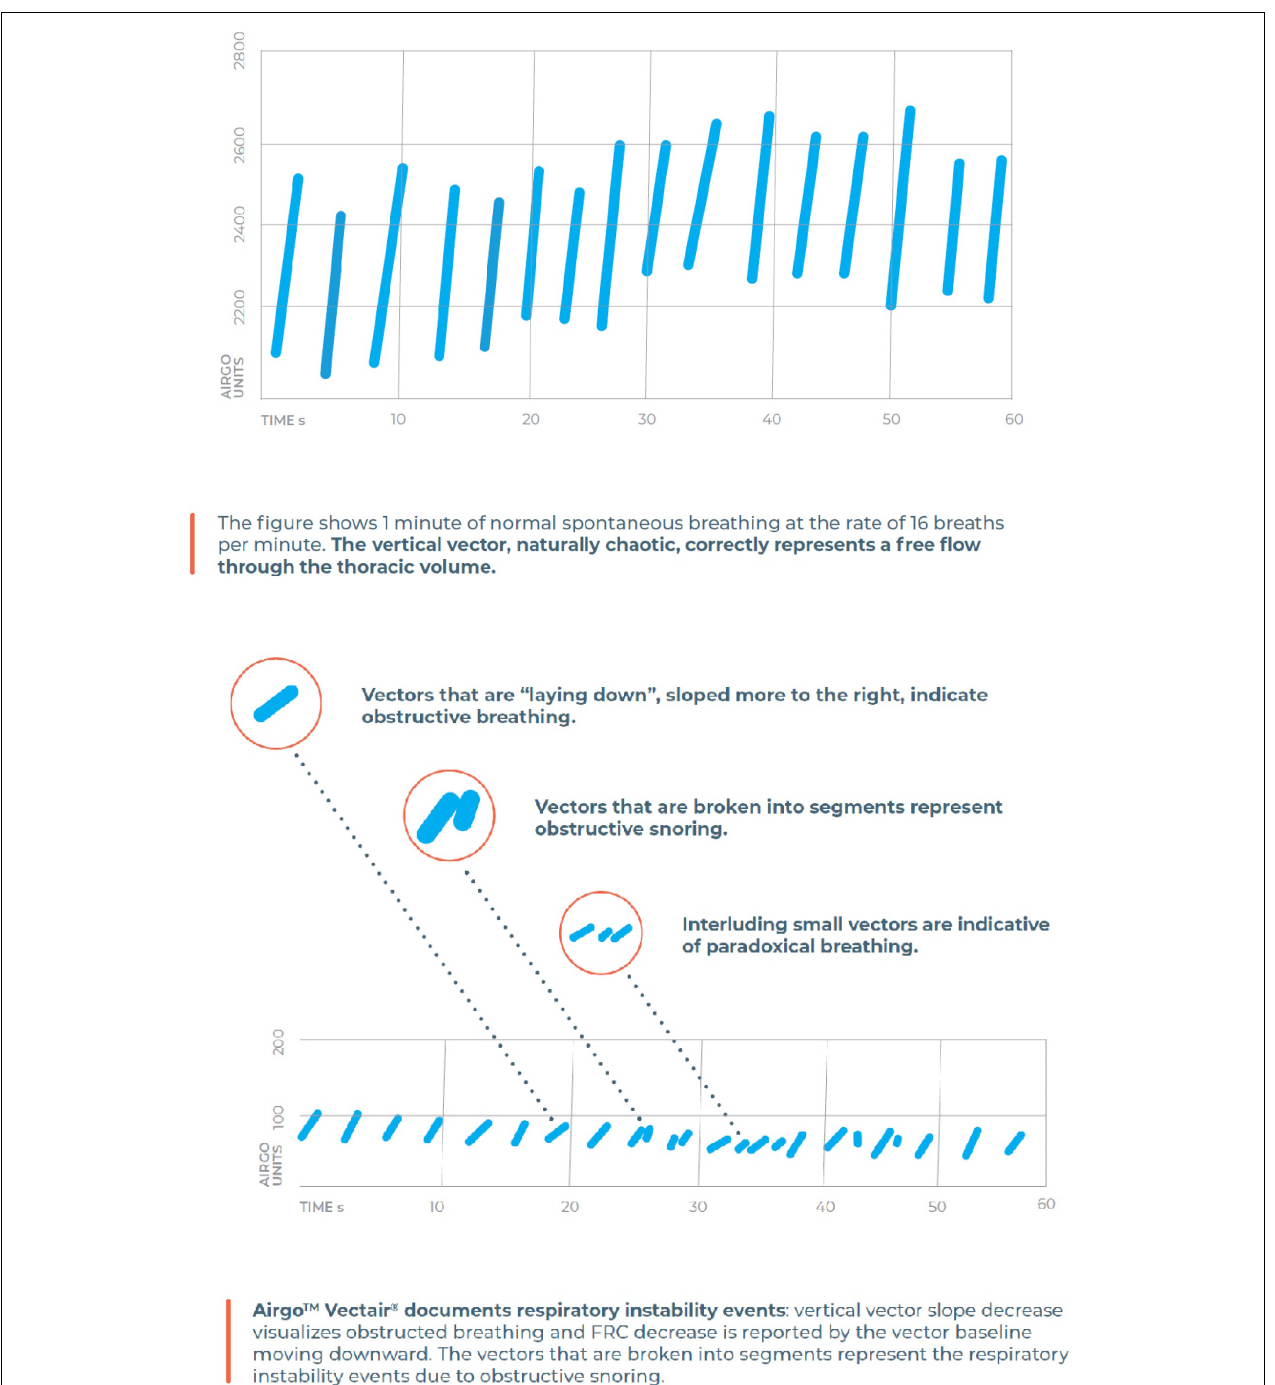
FIGURE 2 | The algorithm of Airgo TM transforms every breath into a vector with a specific length (corresponding to tidal volume), a baseline (corresponding to the punctual functional residual capacity) and a shape here described as proportional to upper airway